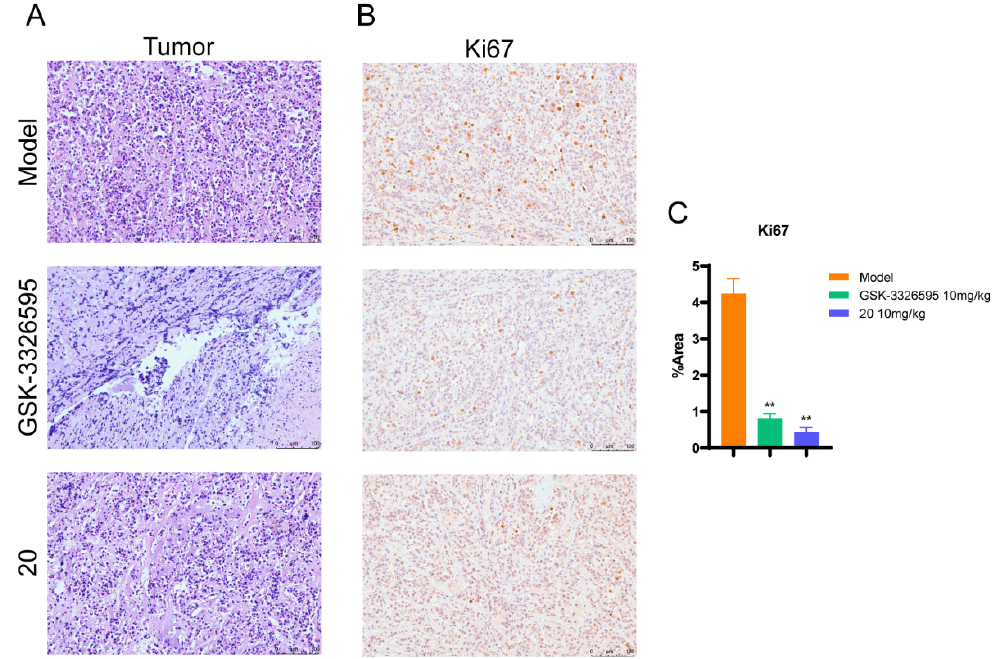
Figure 7. H&E staining and immunohistochemical analysis of Ki-67 expression in vivo. ( A ) Hematoxylin-eosin staining (H&E) analysis of tumor of GSK-3326595 and compound 20 treatment. ( B ) Immunohistochemical analysis of Ki67 in vivo. ( C ) Percentage of immunohistochemically stained dots. * p < 0.05 vs. model, ** p < 0.01.